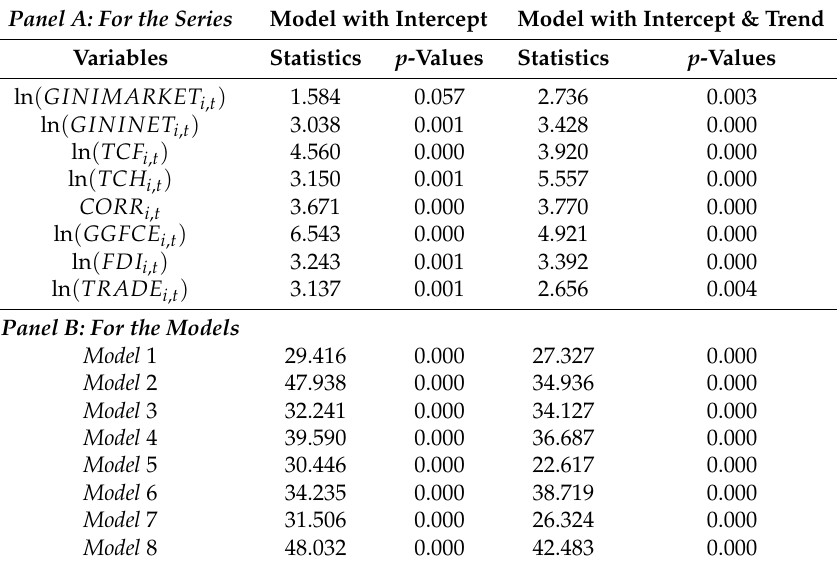
Table 2. Cross-sectional Dependence Tests